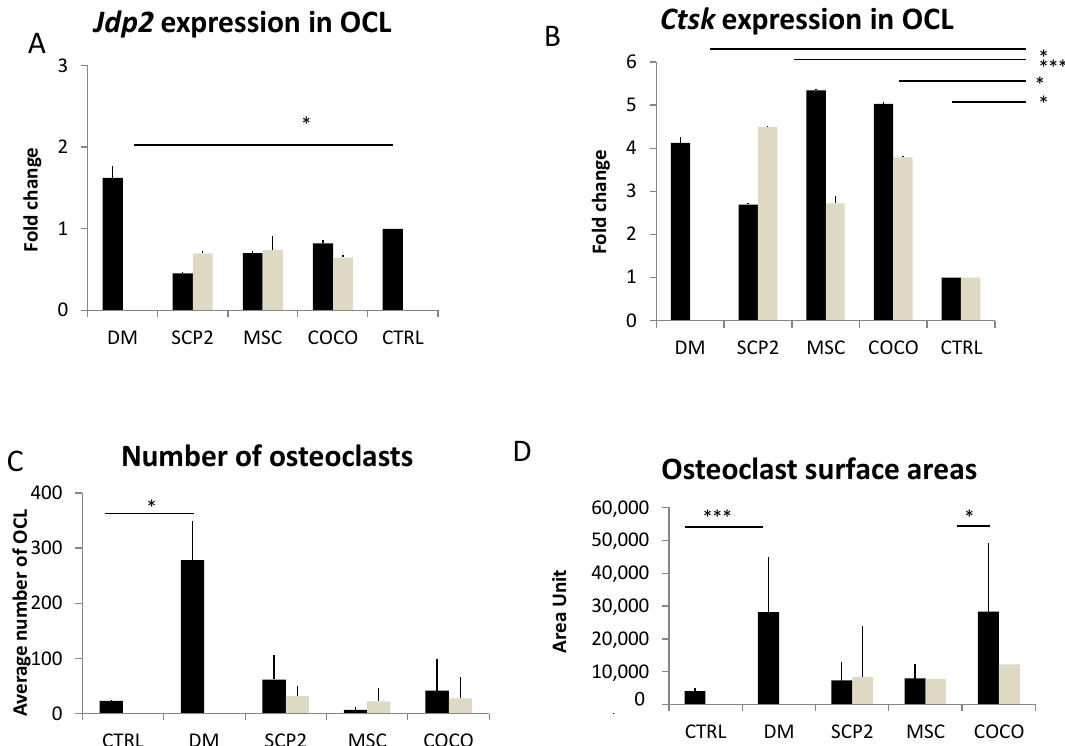
Figure 5. Gef impairs osteoclastogenesis induced by MSC-SCP2 COCO. Expression of jdp2 ( A ) and ctsk ( B ) in osteoclasts cultured either in DM or with CM from SCP2, MSC or SCP2-MSC COCO previously treated (grey bars) or not (black bars) with Gef 1 µg/ml. Significance is compared to undifferentiated pre-osteoclasts (CTRL); Average number ( C ) and average surface area ( D ) of osteoclasts cultured in pre-osteoclast medium (CTRL), in DM or with CM from SCP2, MSC or SCP2-MSC COCO previously treated (grey bars) or not (black bars) with Gef 1µg/mL. * p < 0.05; *** p < 0.01. Gef was not added to CTRL and DM conditions in this context (absence of grey bars).